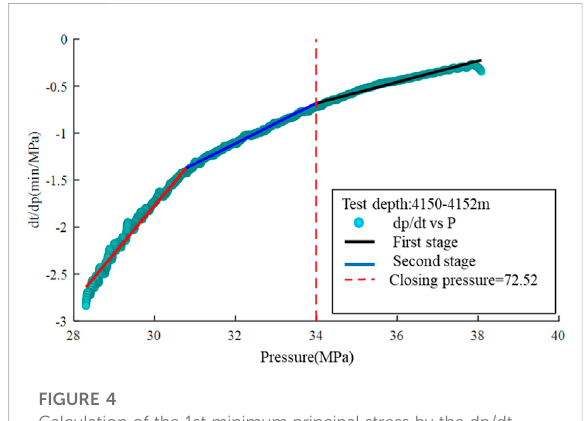
FIGURE 4 Calculation of the 1st minimum principal stress by the dp/dt method.